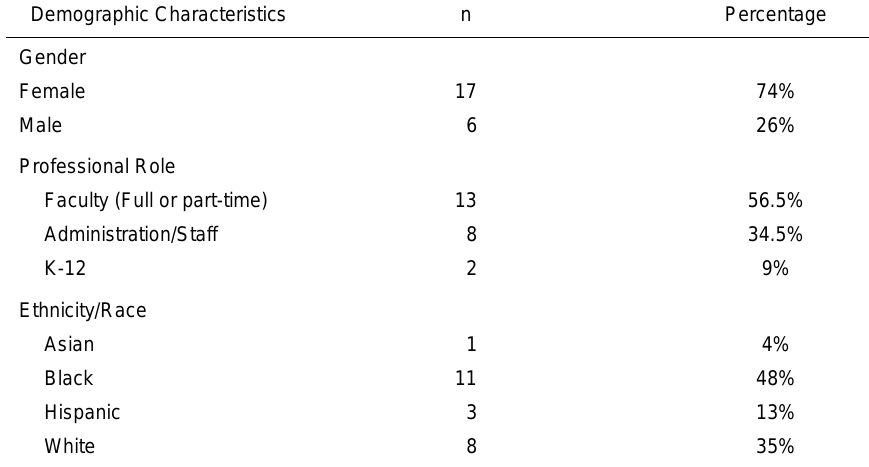
Table 1. Cohort 1 Demographic Profile Demographic